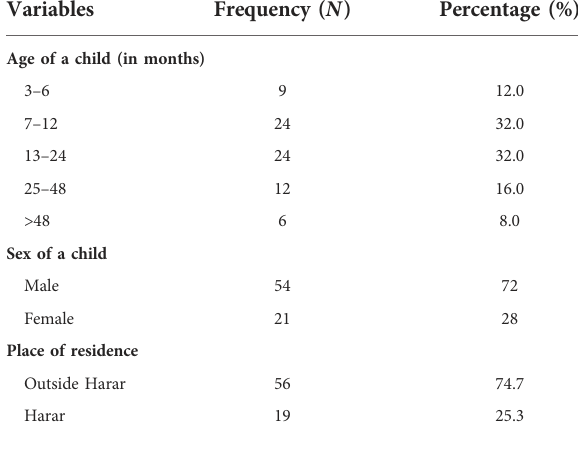
TABLE 1 Socio-demographic characteristics of children admitted and managed for acute intussusception at HFSUH, Eastern Ethiopia, 2021 ( n